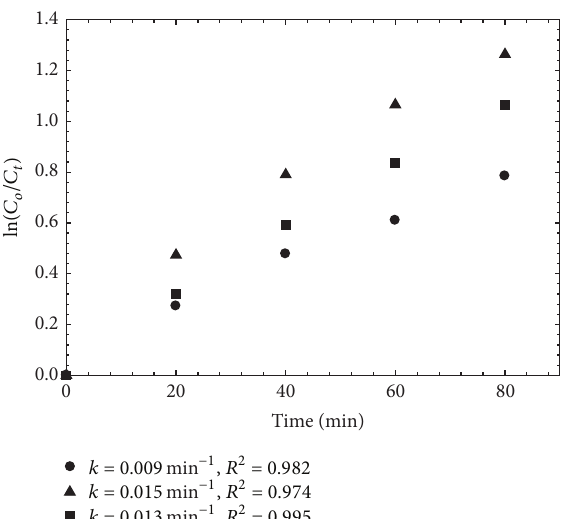
Figure 8: The concentration of methylene blue plotted as ln (𝐶 𝑜 /𝐶 𝑡 ) versus time for ( 󳵳 ) NiO-ZnO NCs, ( ◼ ) NiO-ZnO NCs recycled, and ( e ) ZnO